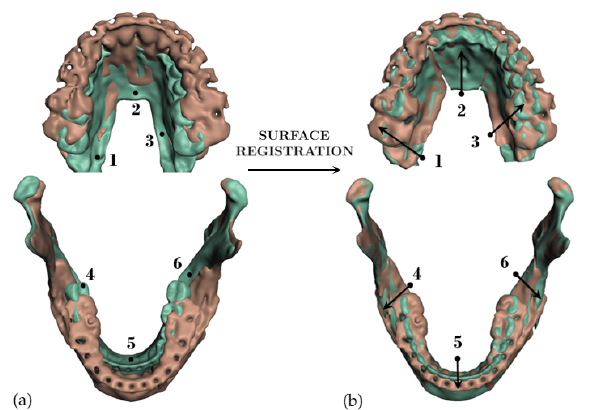
Figure 10. For validation of the proposed simulation methods, we simulate surgical procedures executed on actual interventions. To this end, we identify bone cuts in post-operative scans (brown), we apply those cuts to pre-operative scans (green), and we register the cut bone fragments between both scans. The images show the input pre-operative and post-operative scans ( a ), and again the same scans after registration ( b ). The transformations applied to the individual bone fragments (numbered 1 to 6 in the images) are used as boundary conditions for our planning